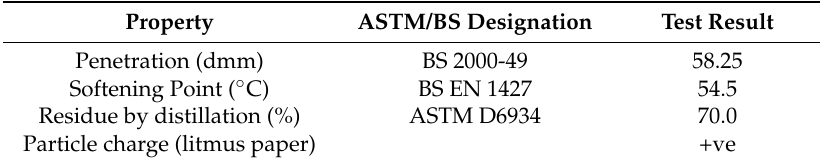
Table 5. Properties of the emulsion